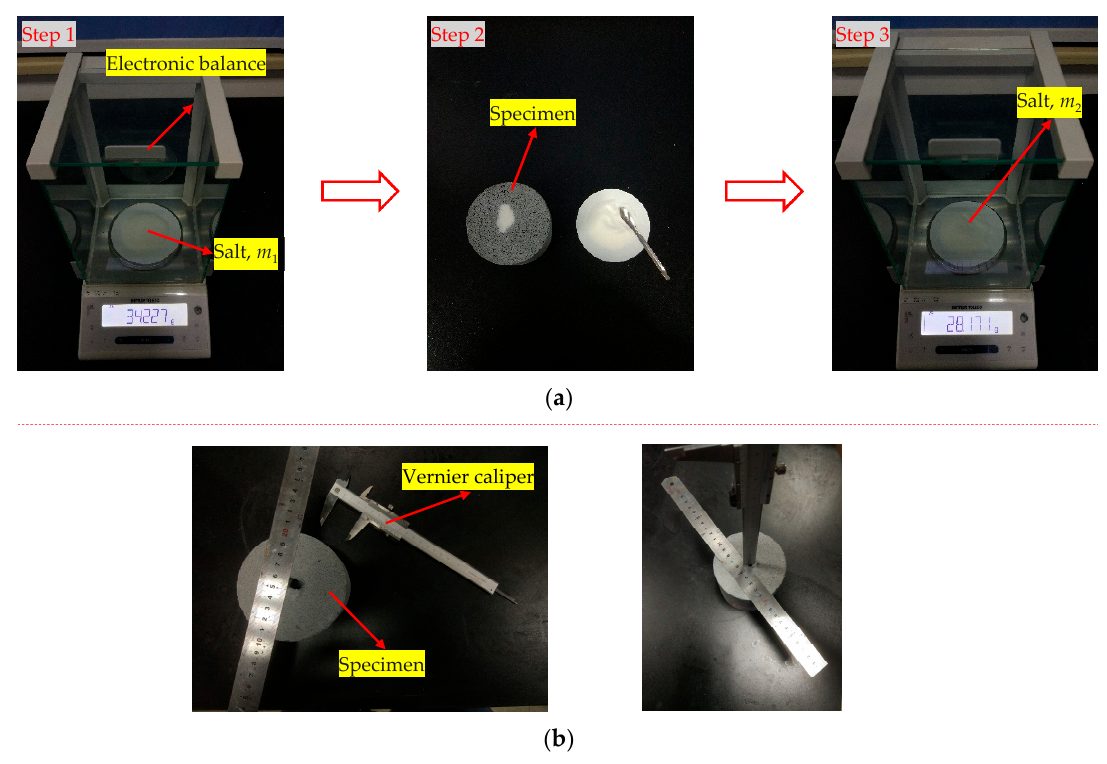
Figure 4. Schematic diagram of measurements of erosion volume and depth: ( a ) Erosion volume; ( b ) Erosion depth.